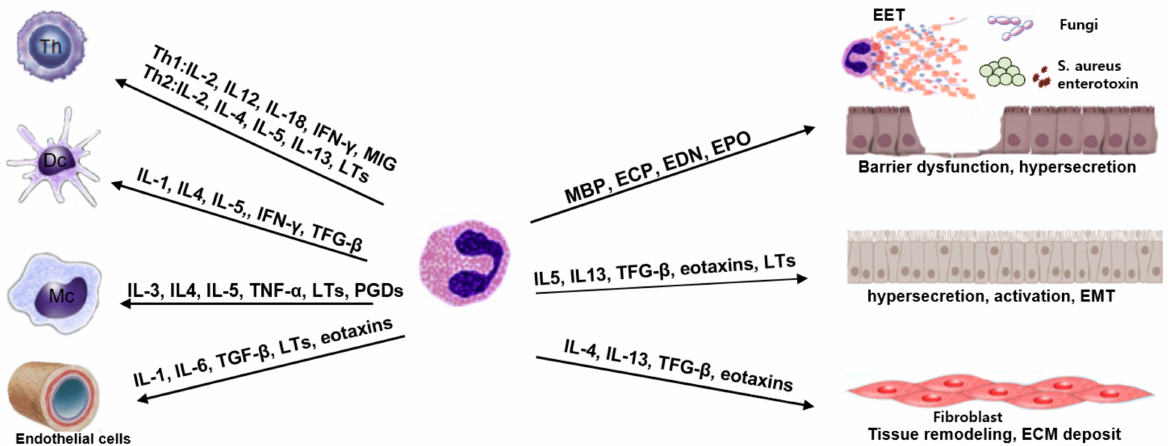
Figure 1. Eosinophil mediators and the interaction of eosinophils with tissue microenvironments. Th: Th cells, Dc: dendritic cells, Mc: mast cells, EET: eosinophil extracellular trap, EMT: epithelial– mesenchymal